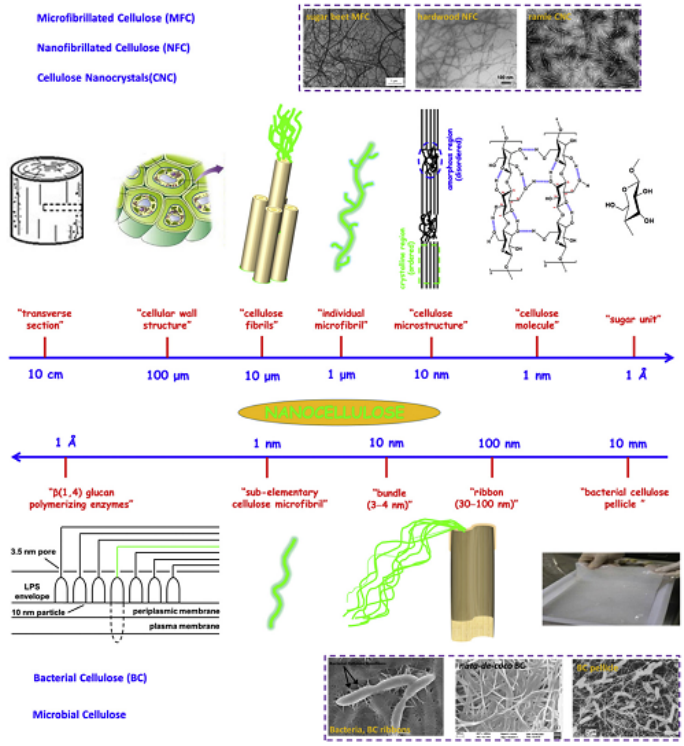
Figure 3. Hierarchical structure of cellulose; top image (from large unit to small unit): cellulose nanocrystals (CNC), micro/nanofibrillated cellulose (MFC and NFC); bottom image (from tiny unit to small unit): bacterial cellulose (BC). Reproduced with permission from [72].